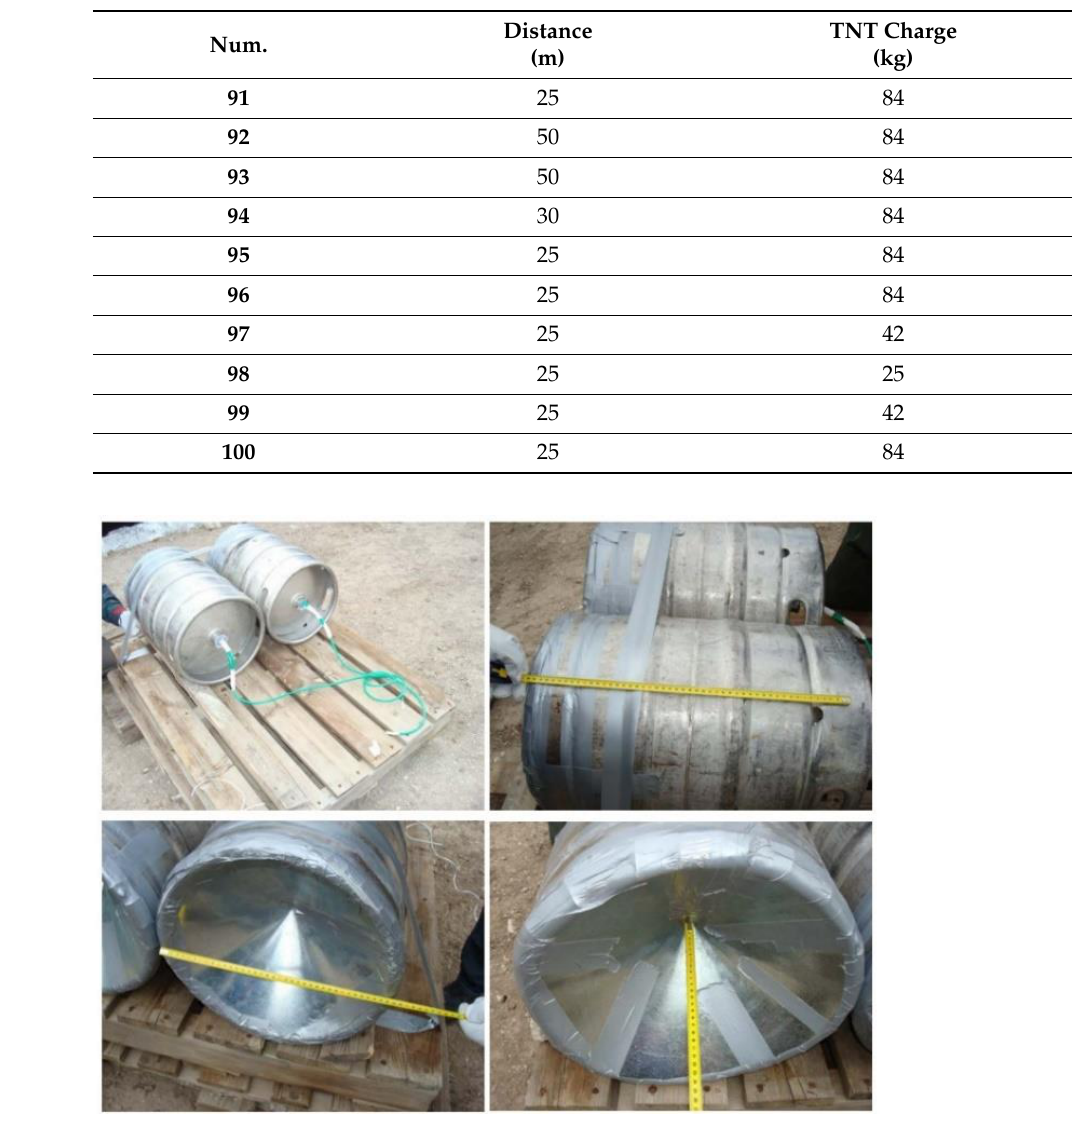
Figure 1. Directed charges of 42 kg of TNT. Different resistant element designs were subjected to the action of the explosive detonated in the open air. These loads were raised from the ground using wooden supports, the distances at which the loads were separated from the structures between 1.5 and 3 m apart (see Figure 2).